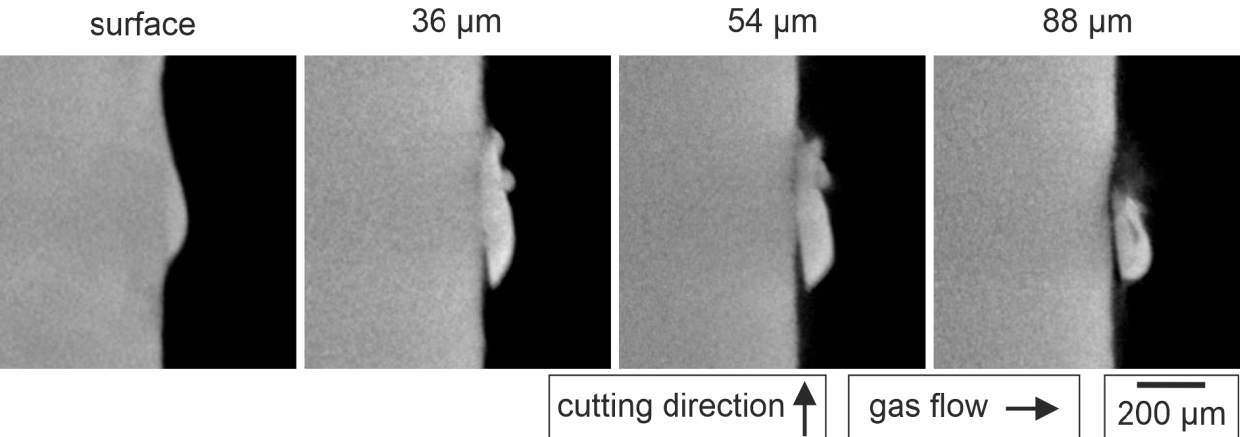
Figure 7. Selection of observation planes of the same re-solidified material droplet in the pre-deformed condition (44%) at different observation depths starting from the surface of the laser-cut edge.